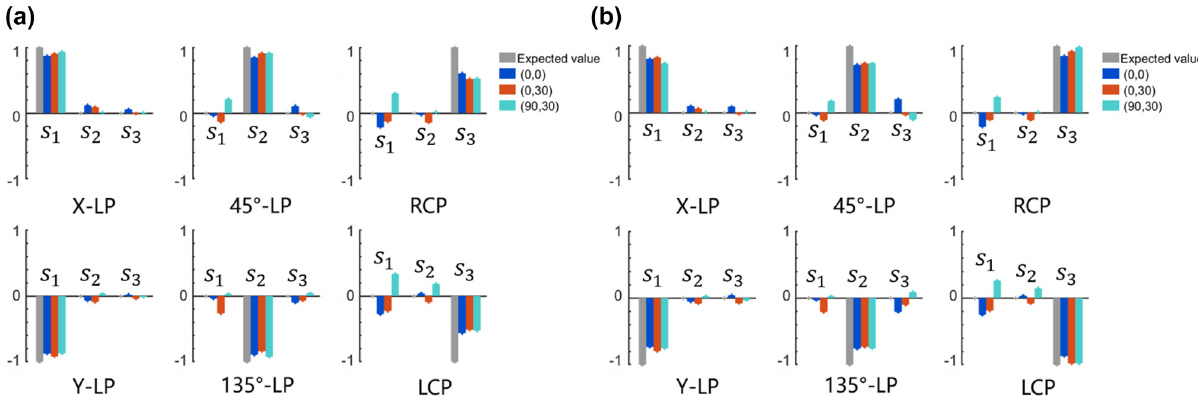
Figure 7: Characterization results of polarization imaging by the BCEM. (a) Stokes parameter reconstruction results of Figure 6(b)–(d). (b) Stokes parameter reconstruction results after normalizing the image intensity of Figure 6(b)–(d). Where gray, blue, red, and cyan bars represent the expected values, and experimental results of sub eyes located at (0,0), (0,30), and (90,30),